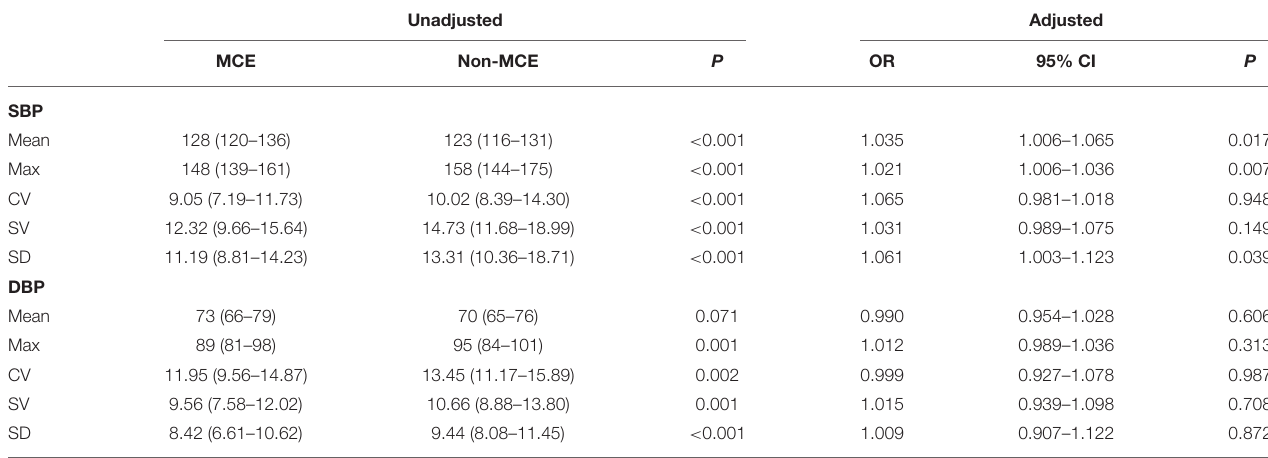
TABLE 2 | Association of blood pressure parameters with the development of MCE. Unadjusted Adjusted MCE Non-MCE P OR 95% CI